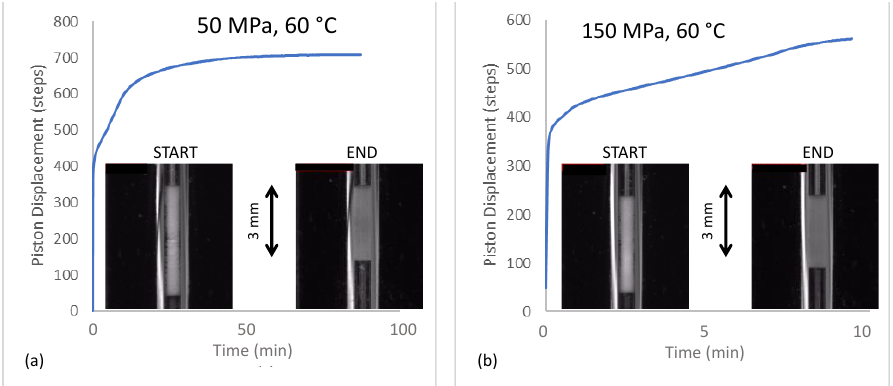
Figure 1. Photographic images of KDP samples at early and late stage CSP with ( a ) 50 MPa uniaxial compression at 60 ◦ C; ( b ) 150 MPa at 60 ◦ C. Additionally, plotted are piston displacements versus cold sintering time for each CSP condition (1 mm displacement ≈ 500 piston steps).